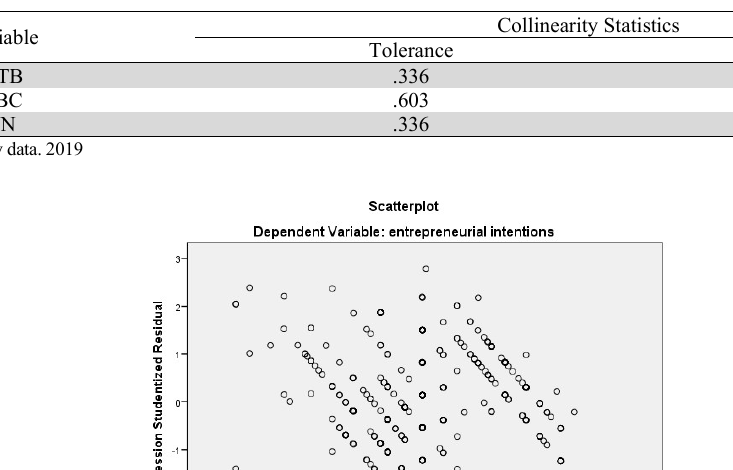
Multicollinearity